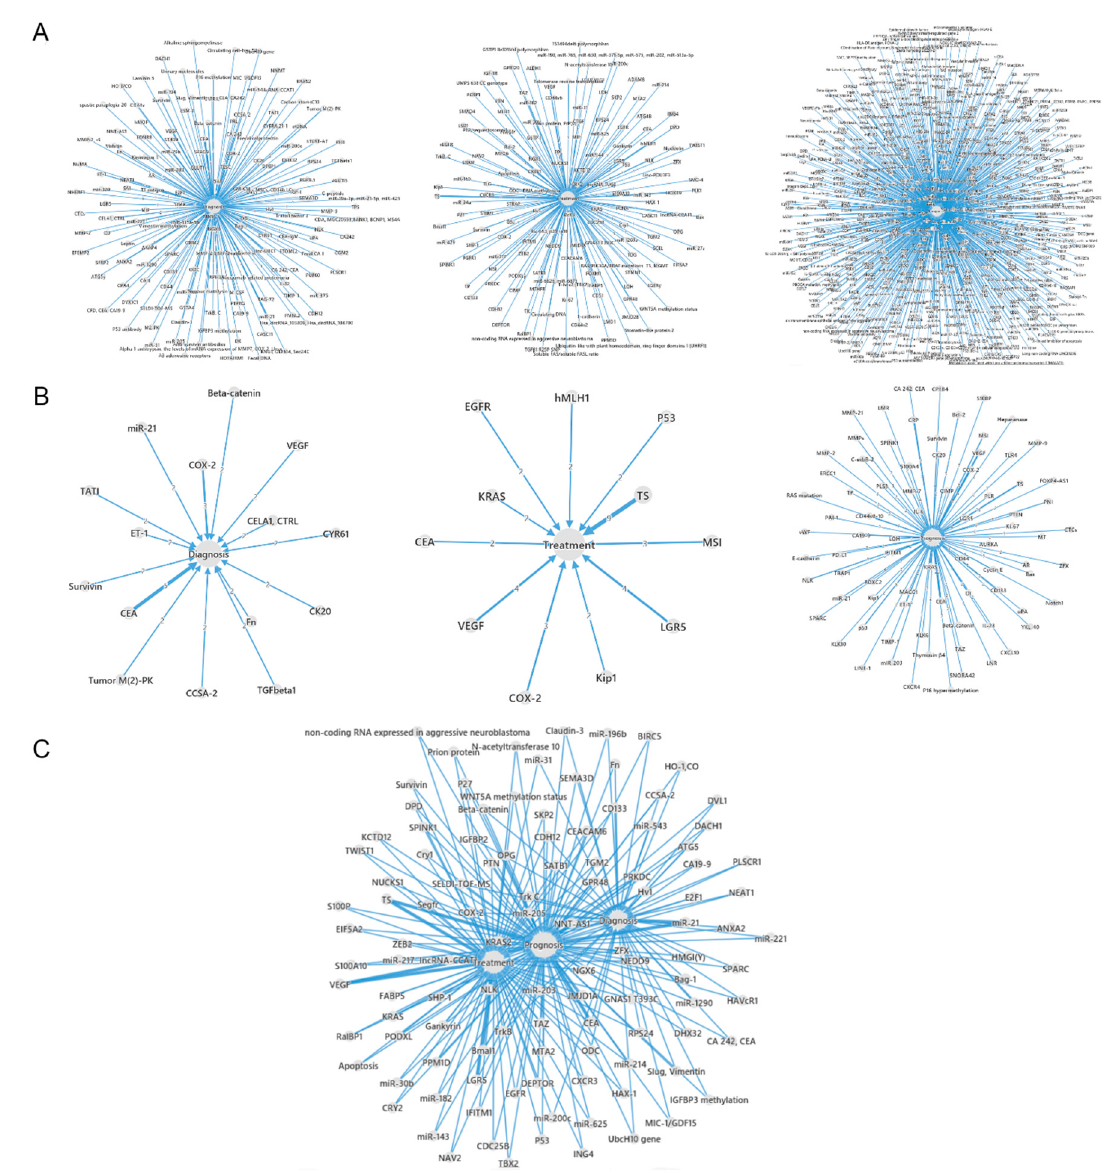
Figure 1. Distributions and interactions of CRC diagnosis, therapy and prognosis biomarkers from the CBD. The numbers mentioned on the lines means the amounts of articles for the correlated biomarkers. ( A ) The CRC biomarkers were classified according to their functions of diagnosis, therapy and prognosis. ( B ) The biomarkers reported by more than 2 articles are presented. ( C ) The interactions of diagnosis, therapy and prognosis biomarkers.